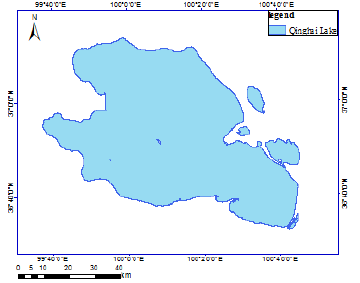
Figure 2. Geographical location of Qinghai lake